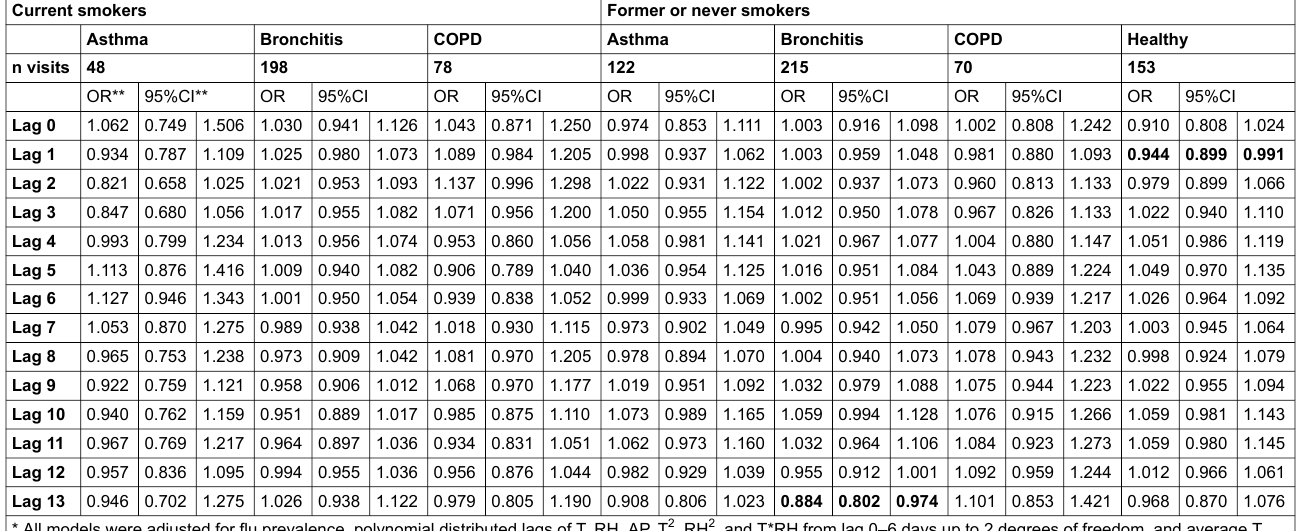
Supplementary file: Table 6 Adjusted OR's* for doctor's visit per 10 µg/m 3 increase in TSP at separate lags in major subcategories of participants after stratification by smoking status as estimated in conditional logistic